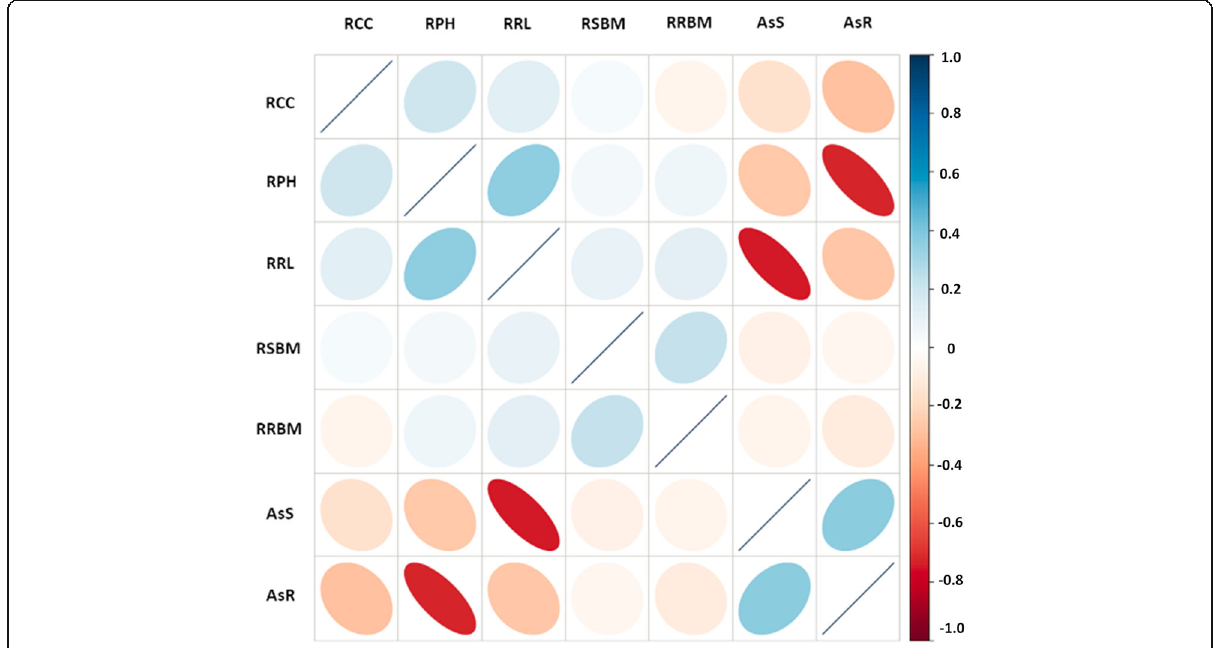
Fig. 3 Heat map is showing the correlation coefficient of As-related traits. RCC: relative chlorophyll content; RPH: relative plant height; RRL: